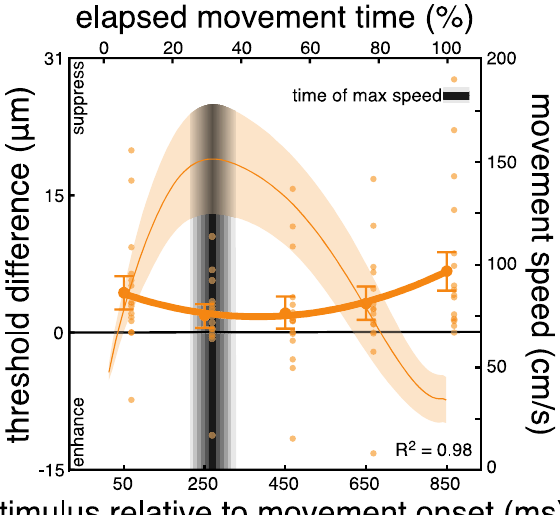
Figure 3. Results of Experiment 2. Differences in detection thresholds between baseline and reaching blocks. Somatosensory processing is hampered early and late in the movement, but it recovers around the time of maximal speed. As expected, the maximal speed is now much higher than in Experiment 1 due to the larger movement amplitude (compare the movement speed values along the right y-axes between Figs. 2 and 3). Details as in Fig.